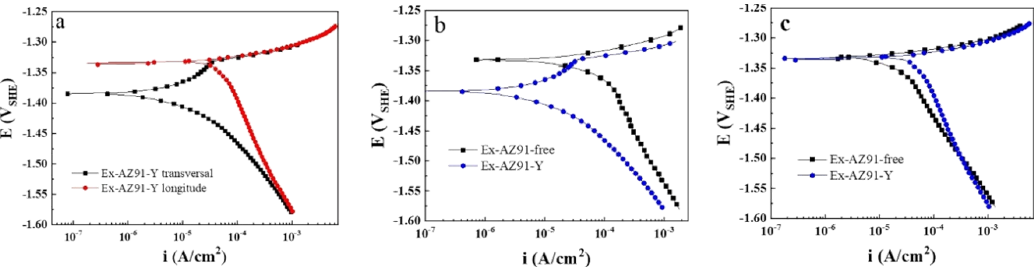
Figure 7. Polarization curves of ( a ) transversal section and longitudinal section of Ex-AZ91-Y alloy, ( b ) transversal section, and ( c ) longitudinal section of Ex-AZ91 alloy before and after the addition of